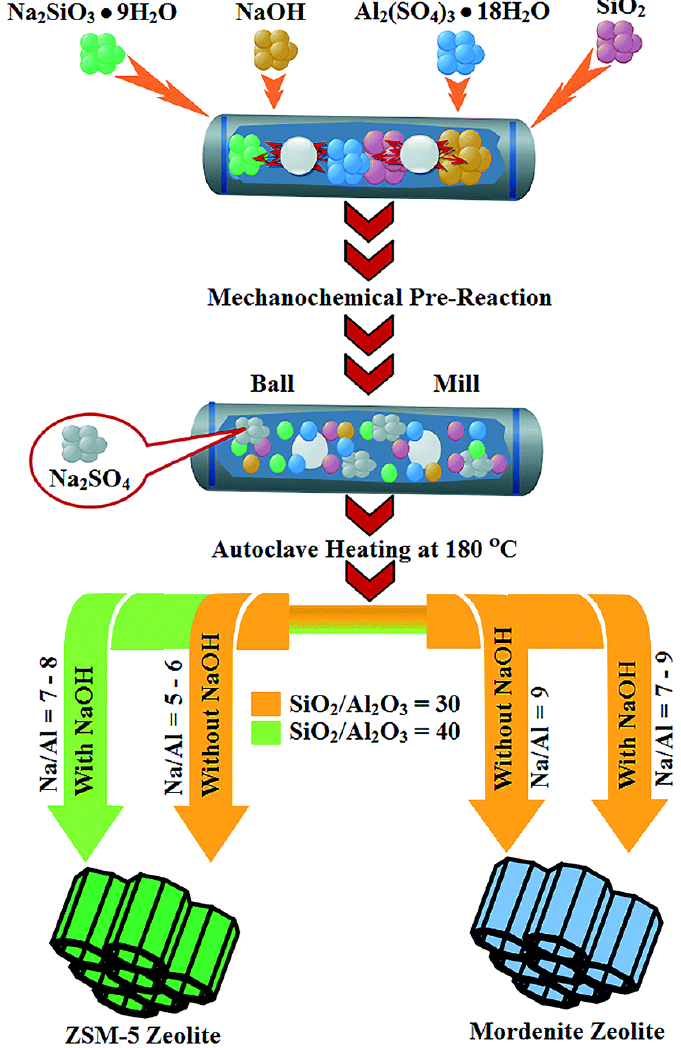
Figure 7. Graphical summary of key reactions steps used and observed phase formation from mechanochemically-assisted solvent-free and template-free zeolite synthesis without using any seeds. (Reprinted from [44]. Published by The Royal Society of Chemistry).